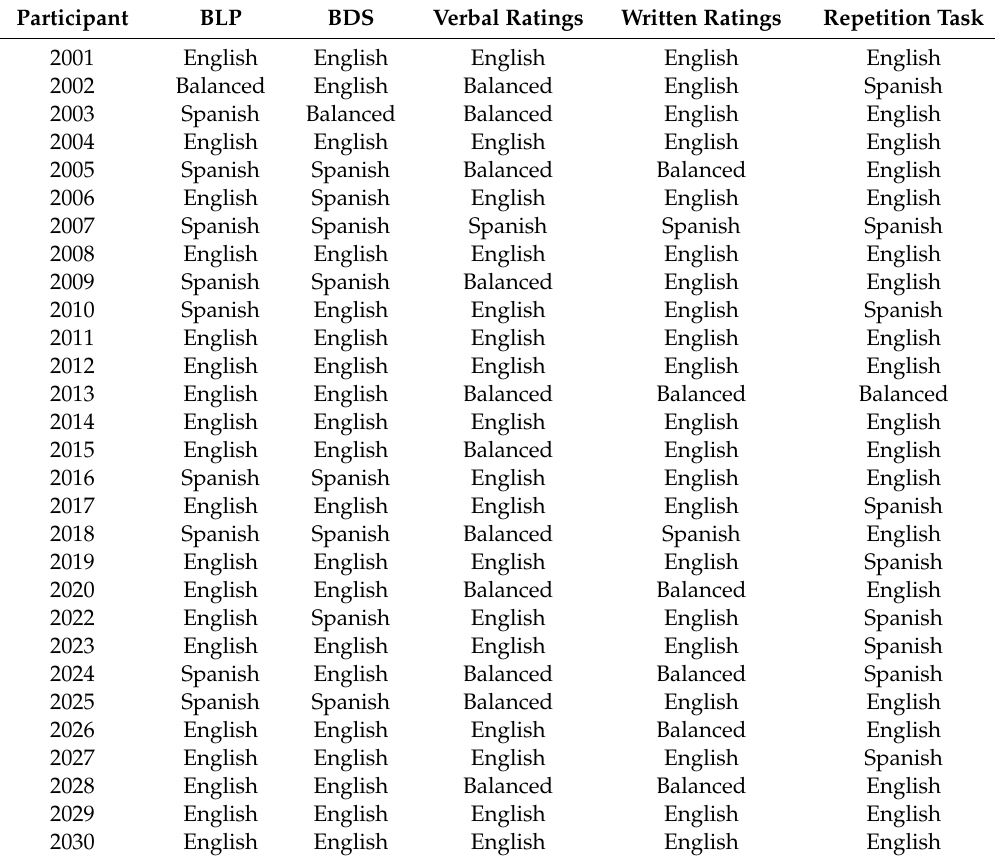
Table 3. Individual dominance